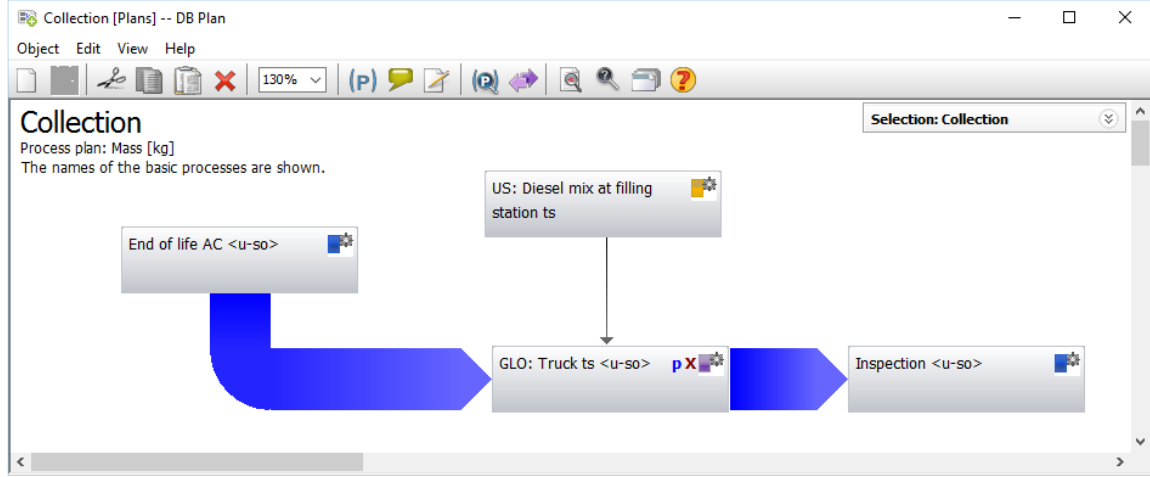
Figure 2. The collection phase modeling using GaBi.